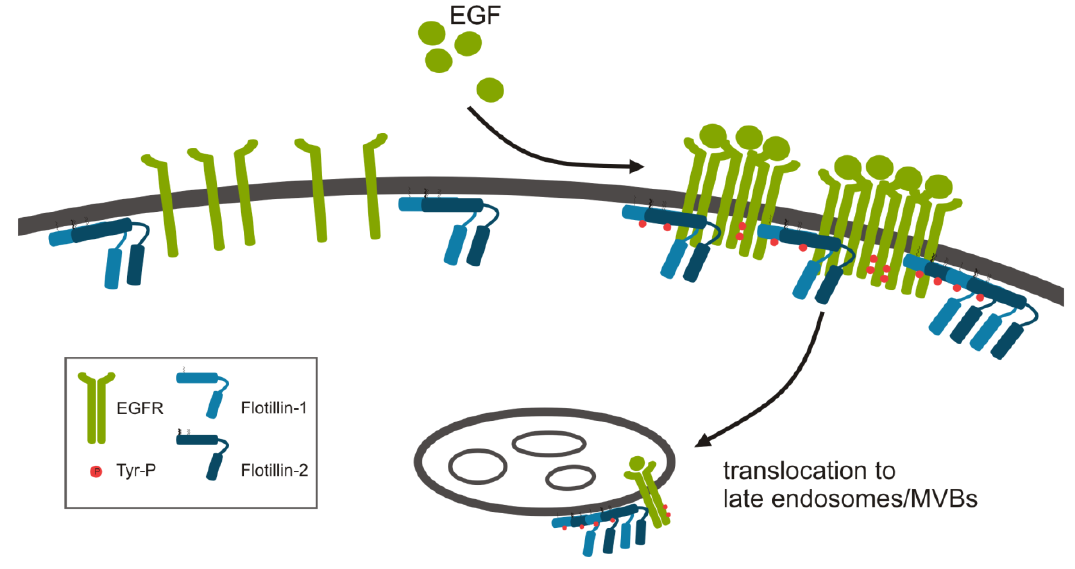
Figure 1. Modifications of flotillins upon epidermal growth factor (EGF) stimulation. Flotillins undergo modifications during RTK signaling. In addition to tyrosine phosphorylation upon EGF stimulation, flotillin hetero-oligomers increase in size and translocate to late